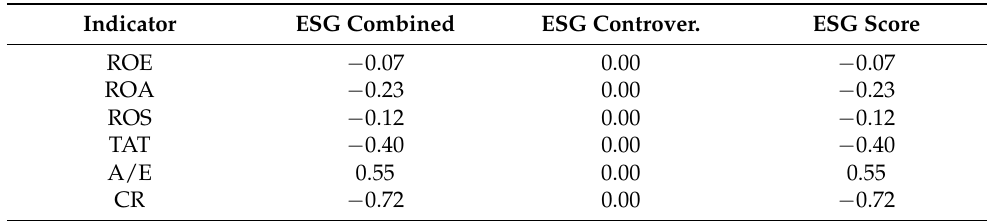
Table 8. Correlations between values of indicators taken into account in research in the case of the enterprise Enea S.A. (period of 2010–2018).